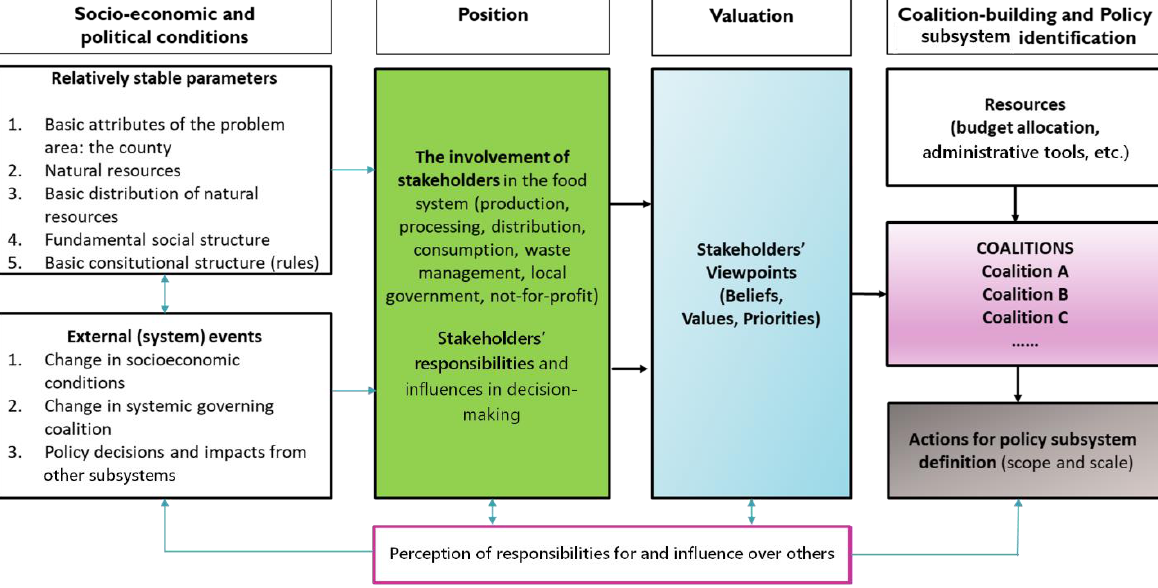
Adapted from Weible and Sabatier, 2009, and Garnett,